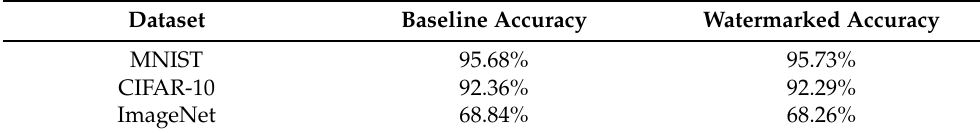
Table 3. Fidelity evaluation of three sets of watermarked models.